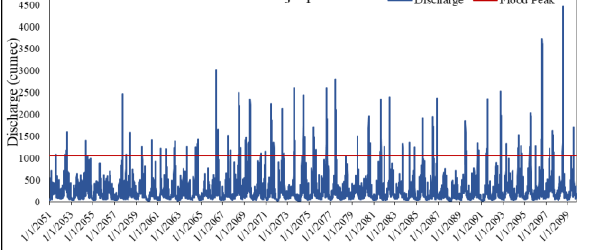
Figure 26 Simulated discharge at Sujanpur outlet for far future time